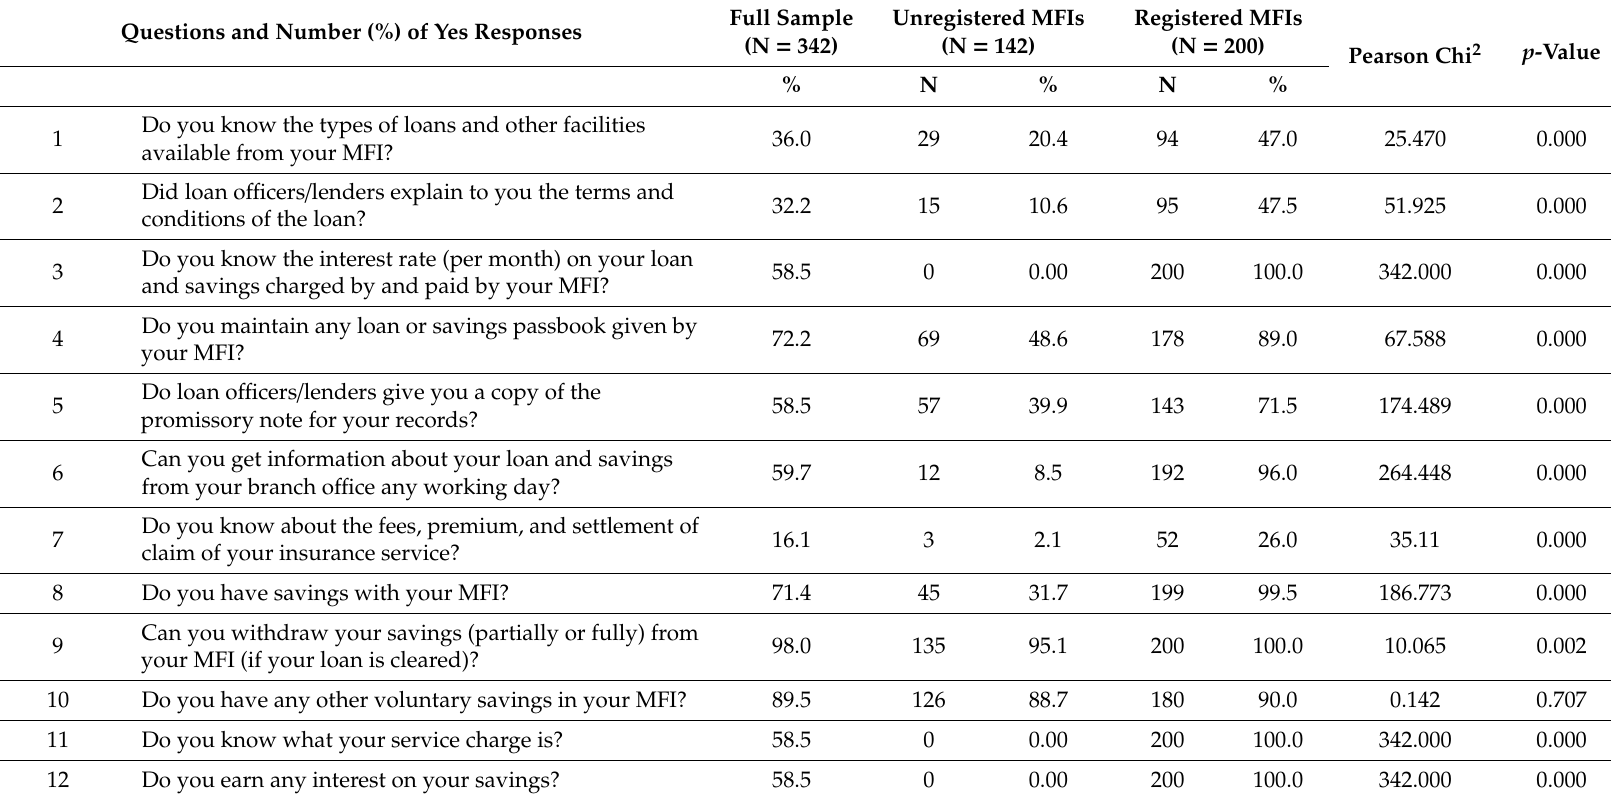
Table 1. Structured interview guide and client yes response